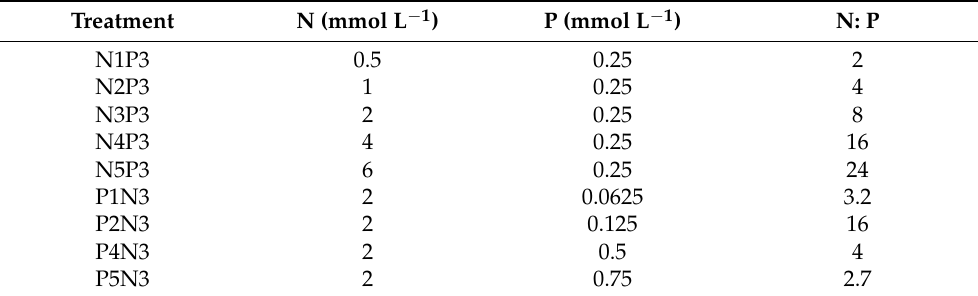
Table 1. The N and P concentrations and ratios in nutrient solutions used in treatments of greenhouse cultivation